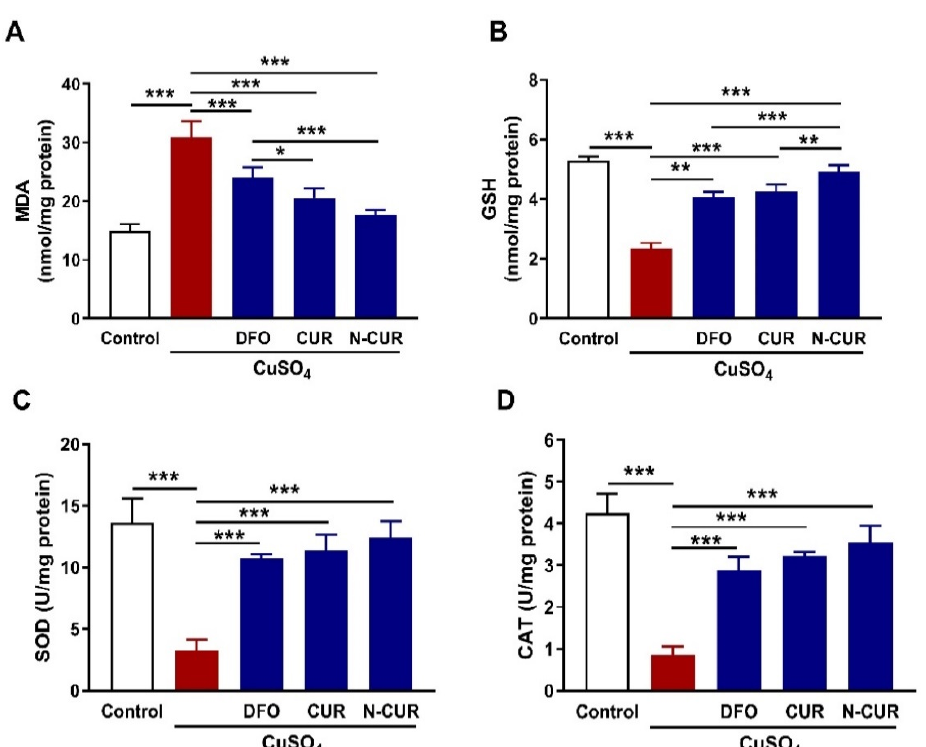
Figure 3. N-CUR and CUR attenuate cardiac oxidative stress in Cu-intoxicated rats. Treatment with N-CUR, CUR, and DFO decreased cardiac MDA ( A ) and increased GSH ( B ), SOD ( C ), and CAT (D) . Data are mean ± SD, ( n = 8). * p < 0.05, ** p < 0.01 and *** p <